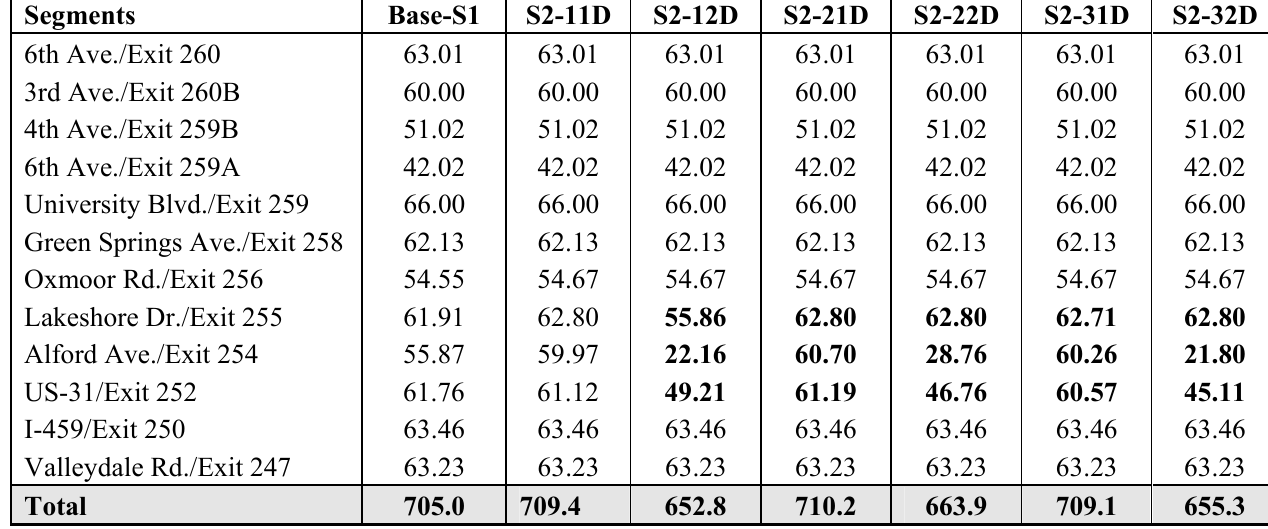
Table 9. Comparison of average speed results with information provision